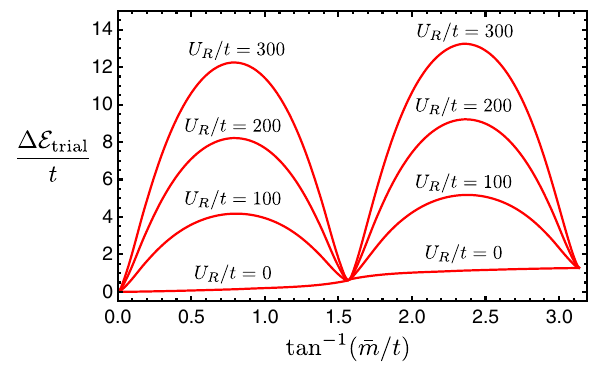
FIG. 15. Variational energetics for the lattice model given by Eqs. (A16) through (A18) with m ¼ 1 , n ¼ 2 , p ¼ 3 , and g ¼ − U . The plot shows the variational energy difference R Δ E [Eq. (A28)] versus tan − 1 ð ¯ m=t Þ , with ¯ m the mean-field trial dimerization order parameter, at various interaction strengths. For any U , the variational energy is minimized at ¯ m ¼ 0 — preclud- R ing a transition at the mean-field level. DMRG calculations do capture a dimerization instability, but only at extremely strong =t ≳ 250 [93,94]. Appendix B explains interactions strengths U R the striking difference between the behavior of the two models examined here and in Fig.